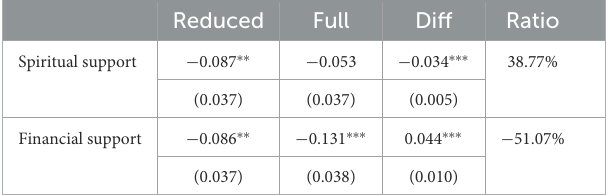
TABLE 5 KHB test